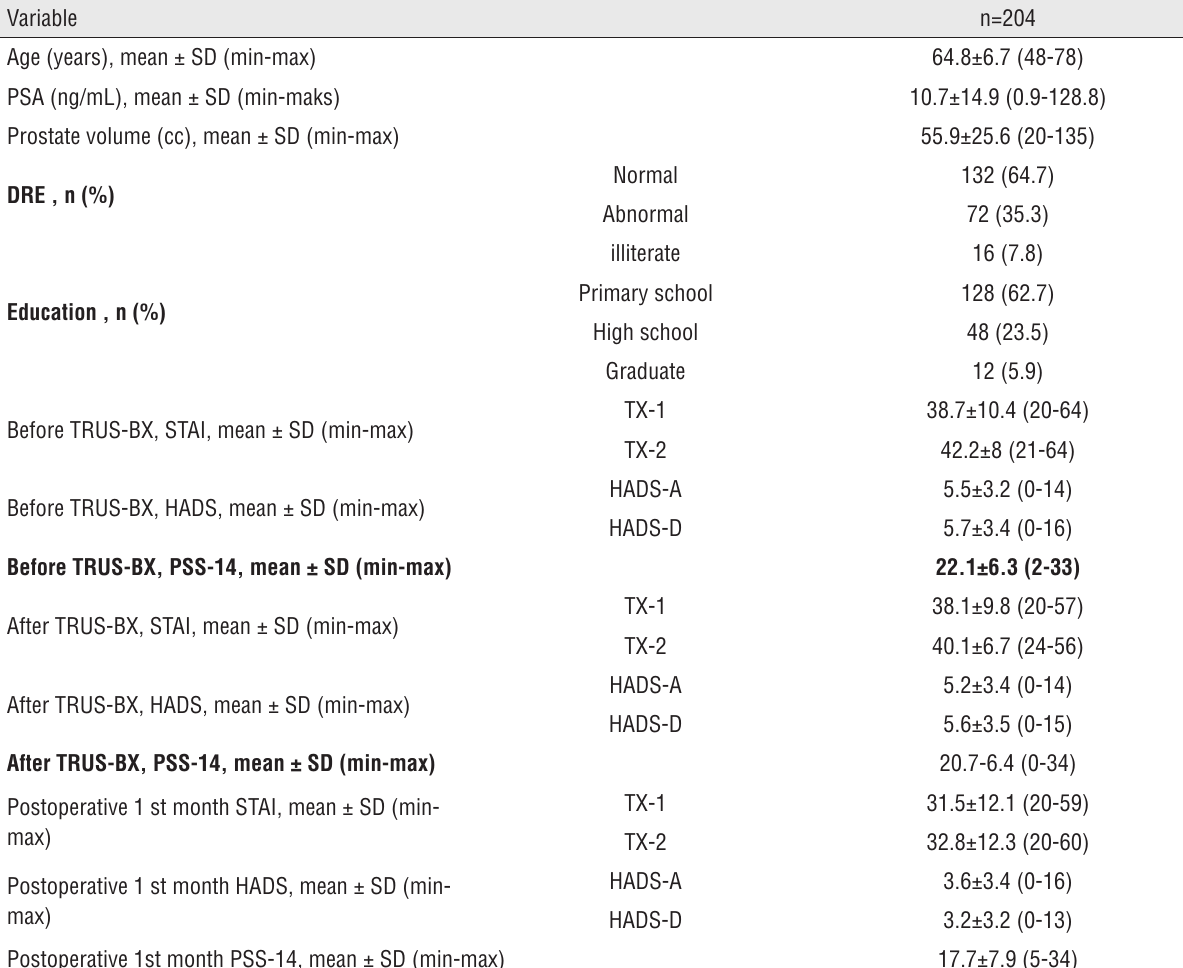
Table 1 - Patients’ demographics and questionnaire